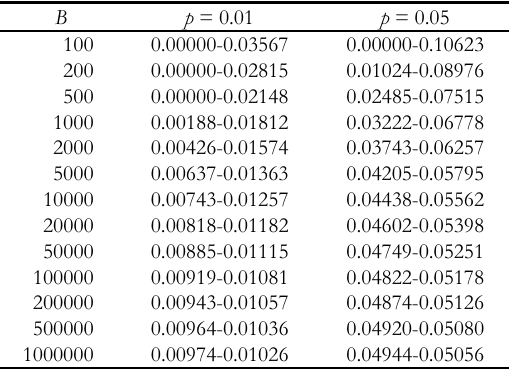
99% probability intervals for estimated